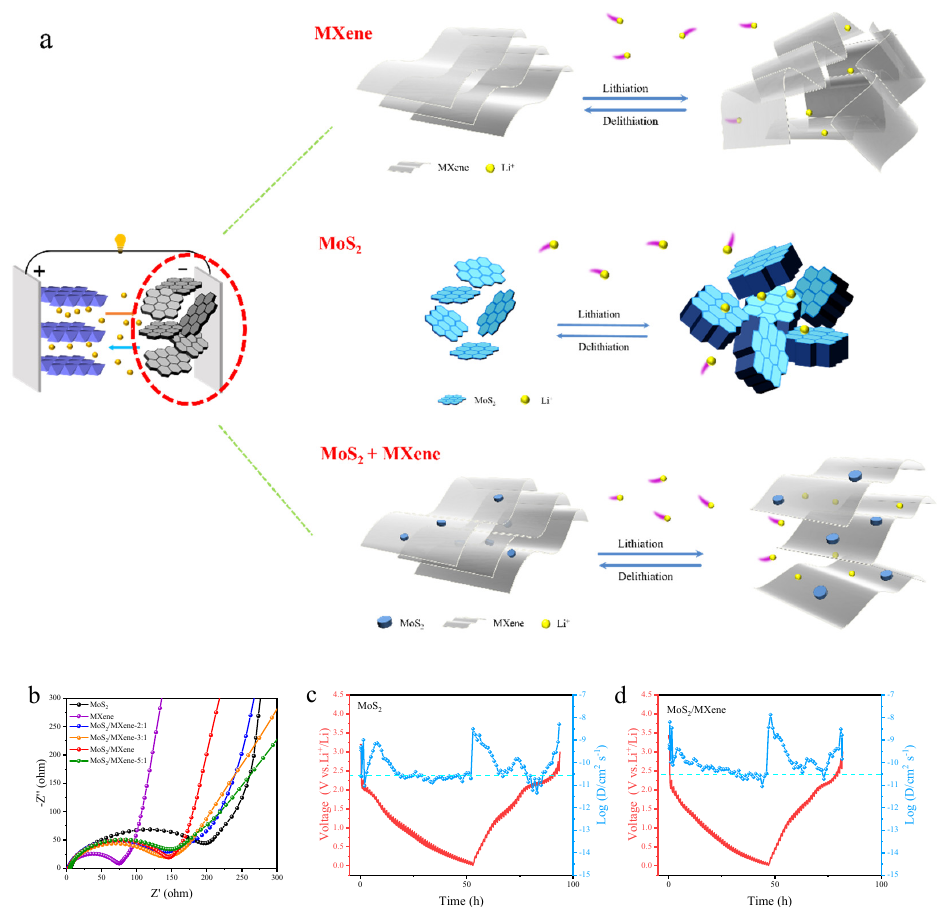
Figure 4. ( a ) Schematic diagram of the processes of lithiation and de-lithiation in MXene, MoS 2 and MXene/MoS 2 ; ( b ) Nyquist plots of MoS 2 , MXene, MoS 2 /MXene − 2:1, MoS 2 /MXene − 3:1, MoS 2 /MXene and MoS 2 /MXene − 5:1 after the first charge/discharge cycle; GITT results of ( c ) MoS 2 and ( d ) MoS 2 /MXene.